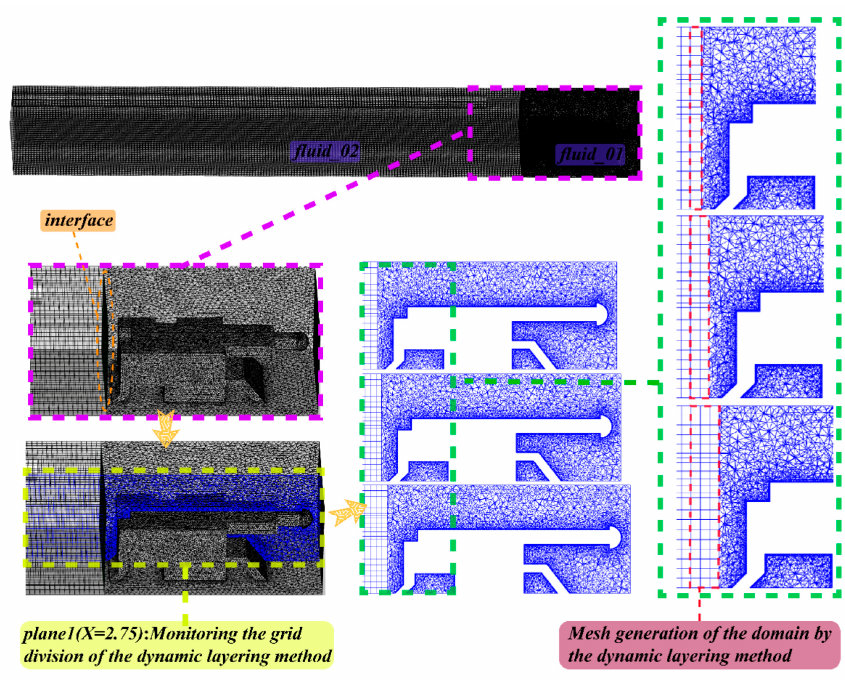
Figure 7. Dynamic mesh model grid generation.